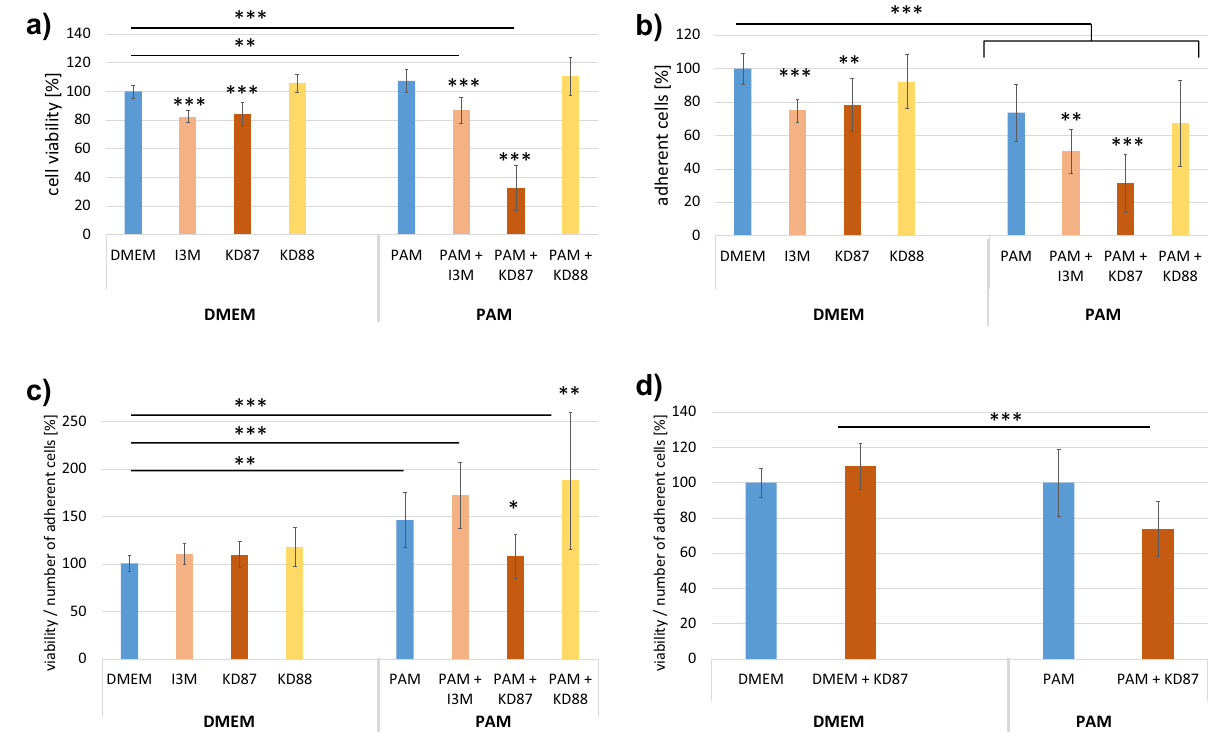
Figure 3. Viability and cell number of A431 cells after combined influence of PAM and small molecules. ( a ) Cell viability was dramatically reduced by the combination of PAM + KD87. ( b ) PAM led to significant cell detachment. ( c ) Viability per number of adherent cells (mean values normalised to the DMEM control). PAM led to a significant increase in viability per number of adherent cells. KD87 counteracted this effect, resulting in values similar to the control. ( d ) The combination of PAM and KD87 caused a significant loss of viability of the remaining adherent cells, indicating a synergistic, anti-cancer effect. The mean values of DMEM and PAM are set 100%. (Indirubin derivatives I3M, KD87, KD88 with 10 µM.Tukey’s multiple comparisons test, * compared with the respective control (blue columns); n = 3, mean ±